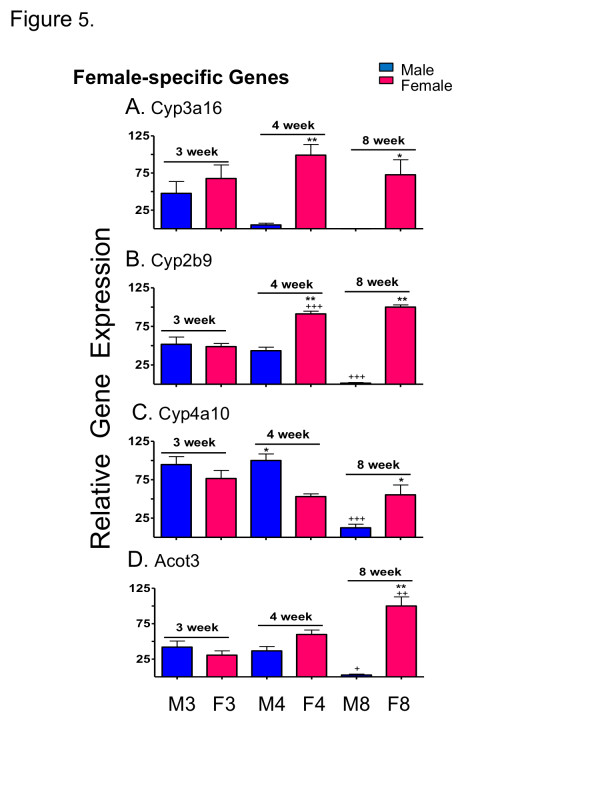
qPCR analysis of female-specific genes. qPCR analysis of relative RNA levels in male (M) and female (F) livers at 3, 4 and 8 wk. Data shown for the four indicated adult female-specific genes are normalized to the 18S RNA of each sample, and based on n = 9-10 individuals (mean ± SEM). Statistical analysis was as described in Figure 4. Very similar results were obtained by microarray analysis (Additional file 9).